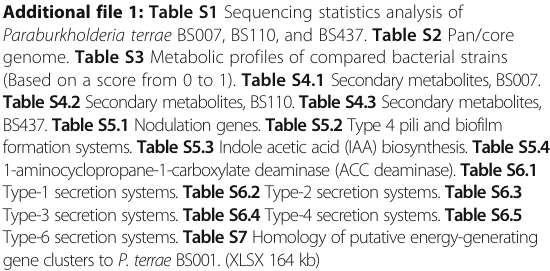
genome. Table S3 Metabolic profiles of compared bacterial strains (Based on a score from 0 to 1). Table S4.1 Secondary metabolites, BS007. Table S4.2 Secondary metabolites, BS110. Table S4.3 Secondary metabolites, BS437. Table S5.1 Nodulation genes. Table S5.2 Type 4 pili and biofilm formation systems. Table S5.3 Indole acetic acid (IAA) biosynthesis. Table S5.4 1-aminocyclopropane-1-carboxylate deaminase (ACC deaminase). Table S6.1 Type-1 secretion systems. Table S6.2 Type-2 secretion systems. Table S6.3 Type-3 secretion systems. Table S6.4 Type-4 secretion systems. Table S6.5 Type-6 secretion systems. Table S7 Homology of putative energy-generating gene clusters to P. terrae BS001. (XLSX 164